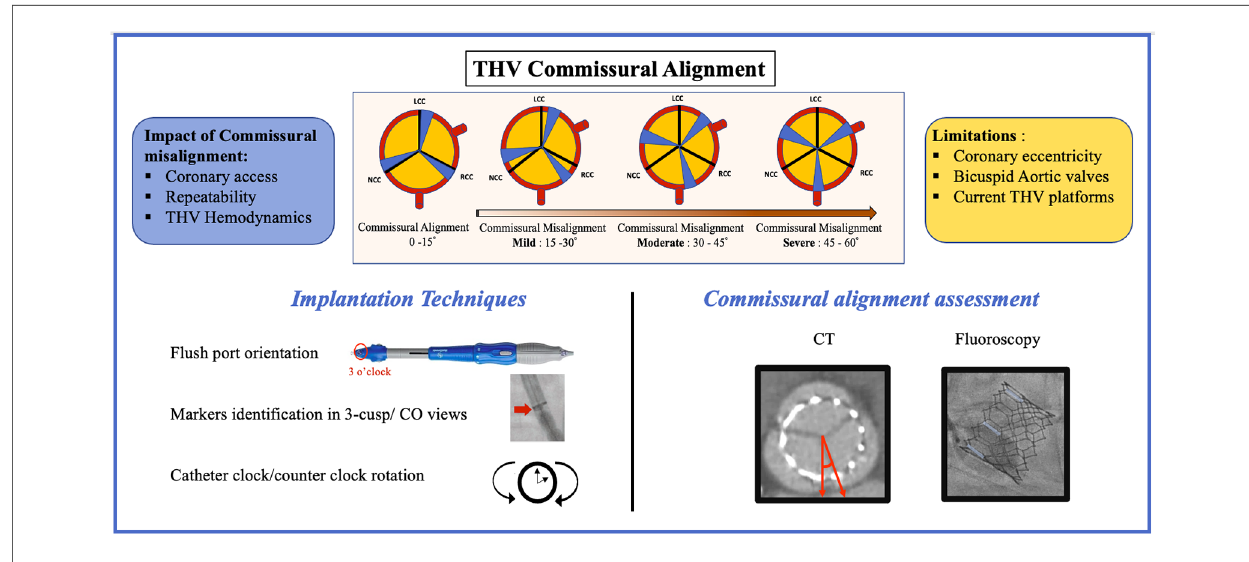
FIGURE 1 THV commissural alignment: classi fi cation, clinical impact, limitations, implantation techniques, and commissural alignment assessment with imaging. CT, computed tomography; CO, cusp overlap; THV, transcatheter heart